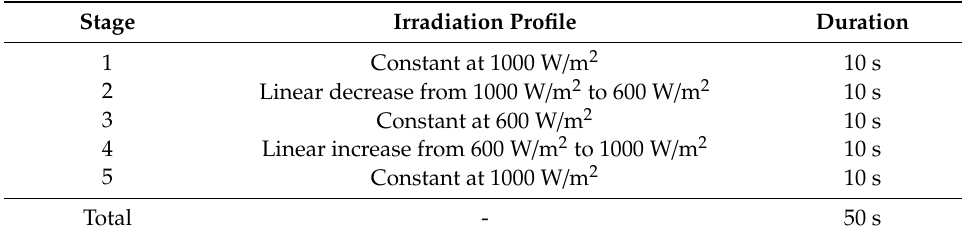
Table 6. Transient radiation test results.